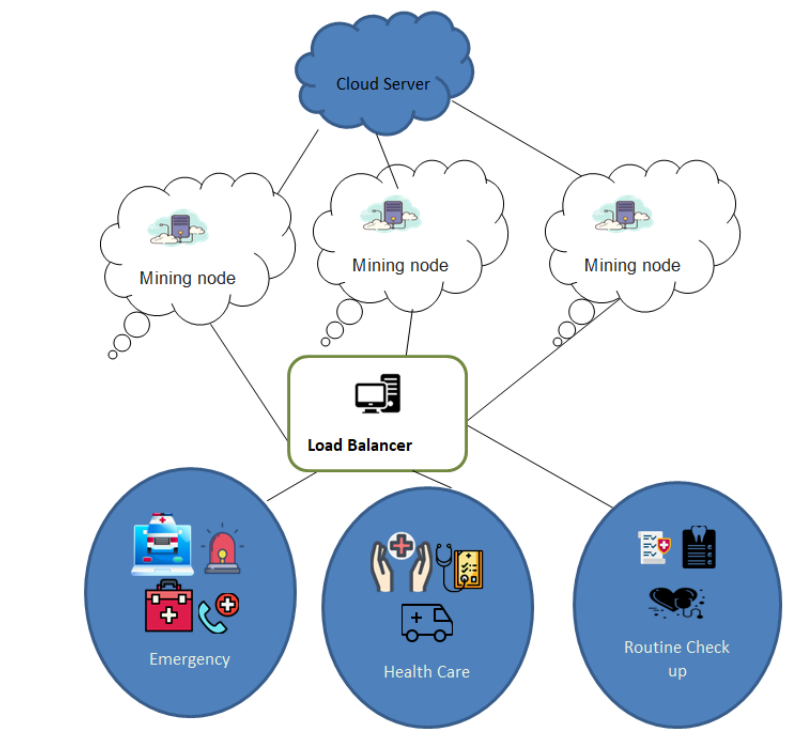
Figure 2. Load balancing in a mining